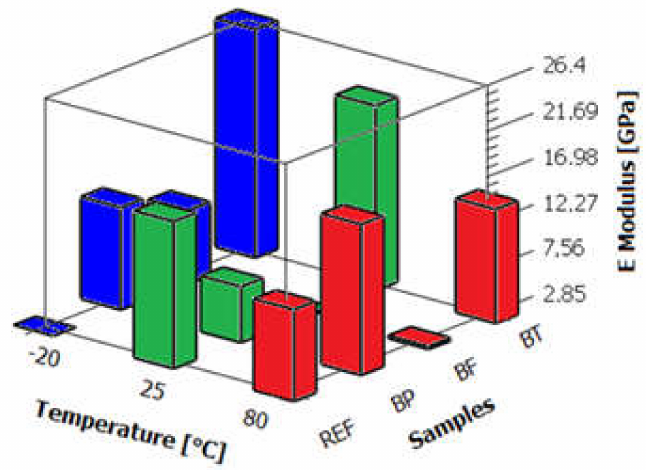
Figure 14. Relation of Young’s modulus E and temperature for VE (REF) sample and VE composites reinforced with basalt powder (BP), basalt fibre (BF) and basalt textile (BT) (Table